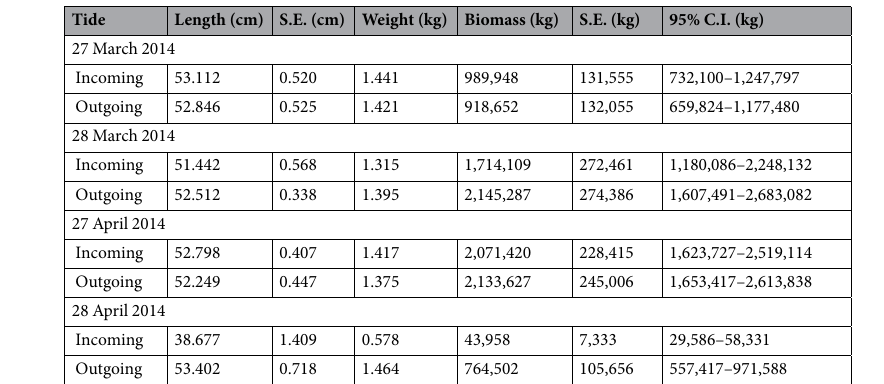
Table 3. Mean total length, weight, and estimated biomass of mature Gulf Corvina ( Cynoscion othonopterus ) per survey. S.E. = standard error; 95% C.I. = 95% confidence interval. Mean total length on the incoming tide of 28 April 2014 reflects the absence of high abundances of large Gulf Corvina within the survey